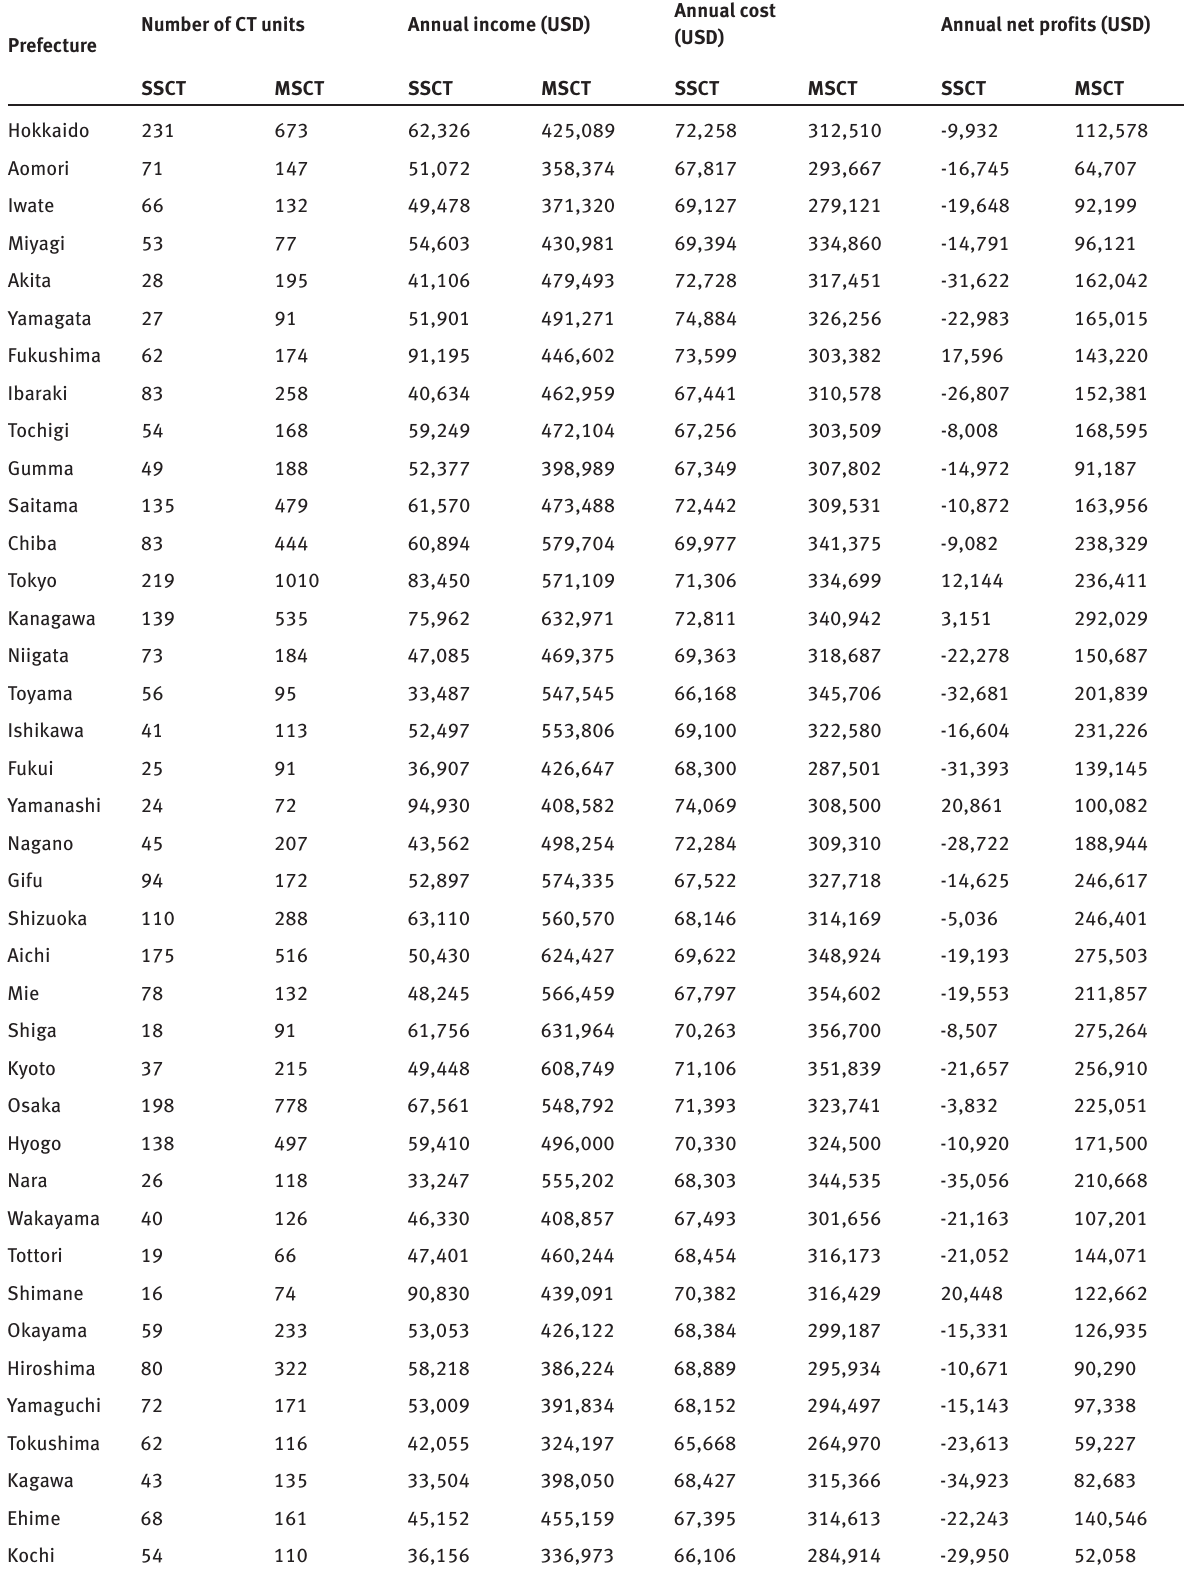
Table 6: Annual net profits from CT in 47